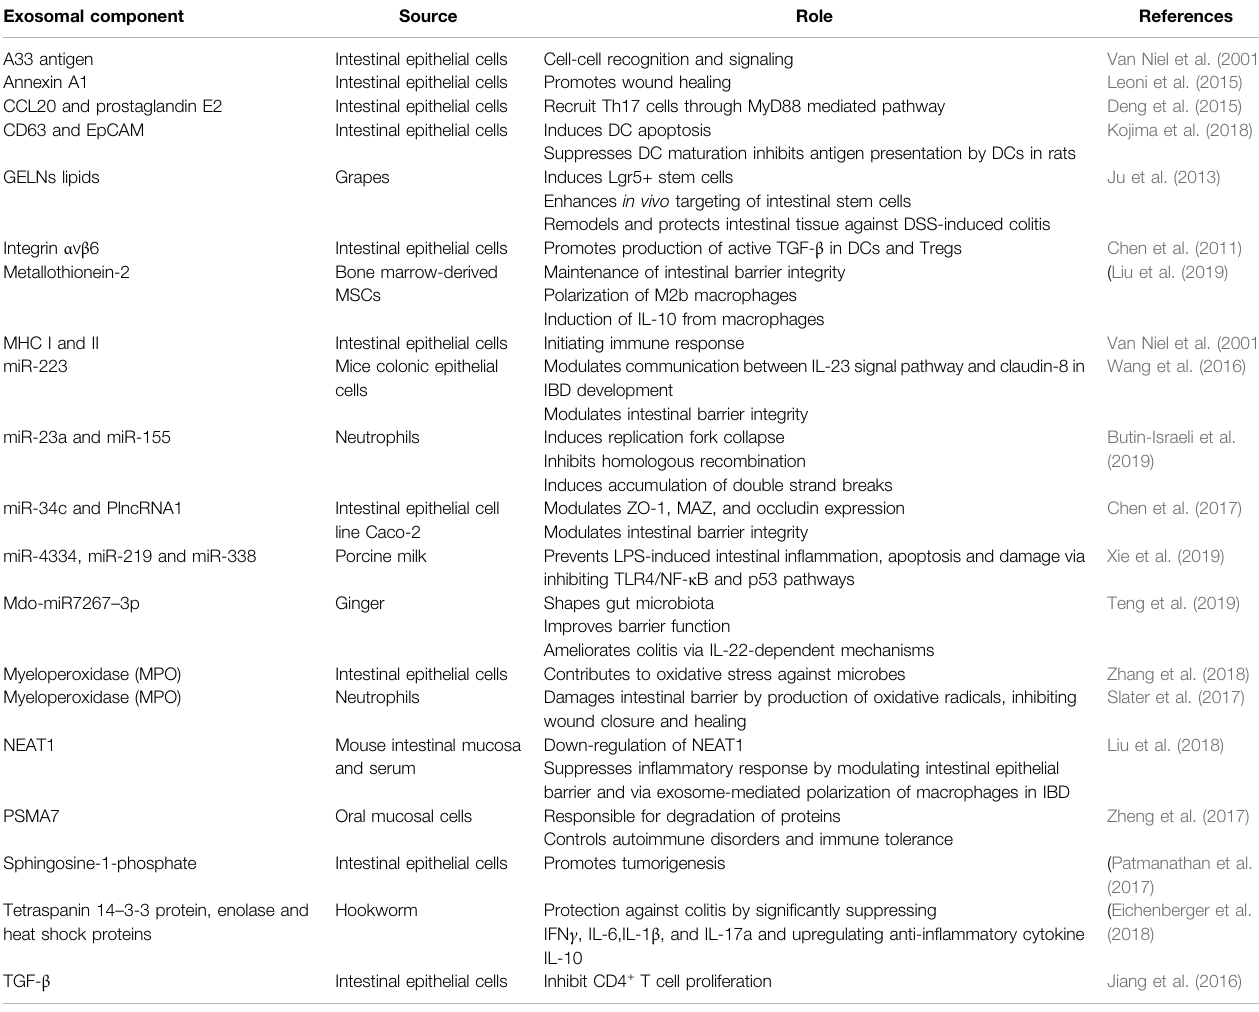
TABLE 1 | Source and function of different extracellular vesicle components in